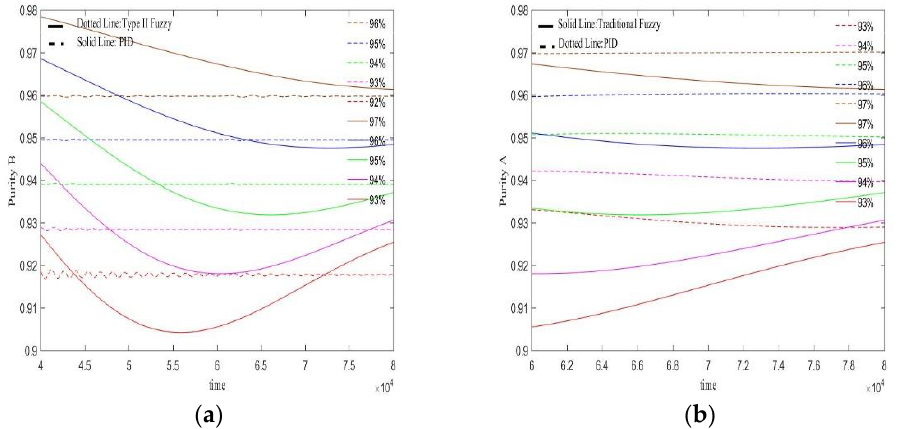
Figure 17. Under the change of the adsorbent parameter H A = 0.01 → 0.03. ( a ) Extraction outlet (material B); ( b ) raffinate outlet (material A).